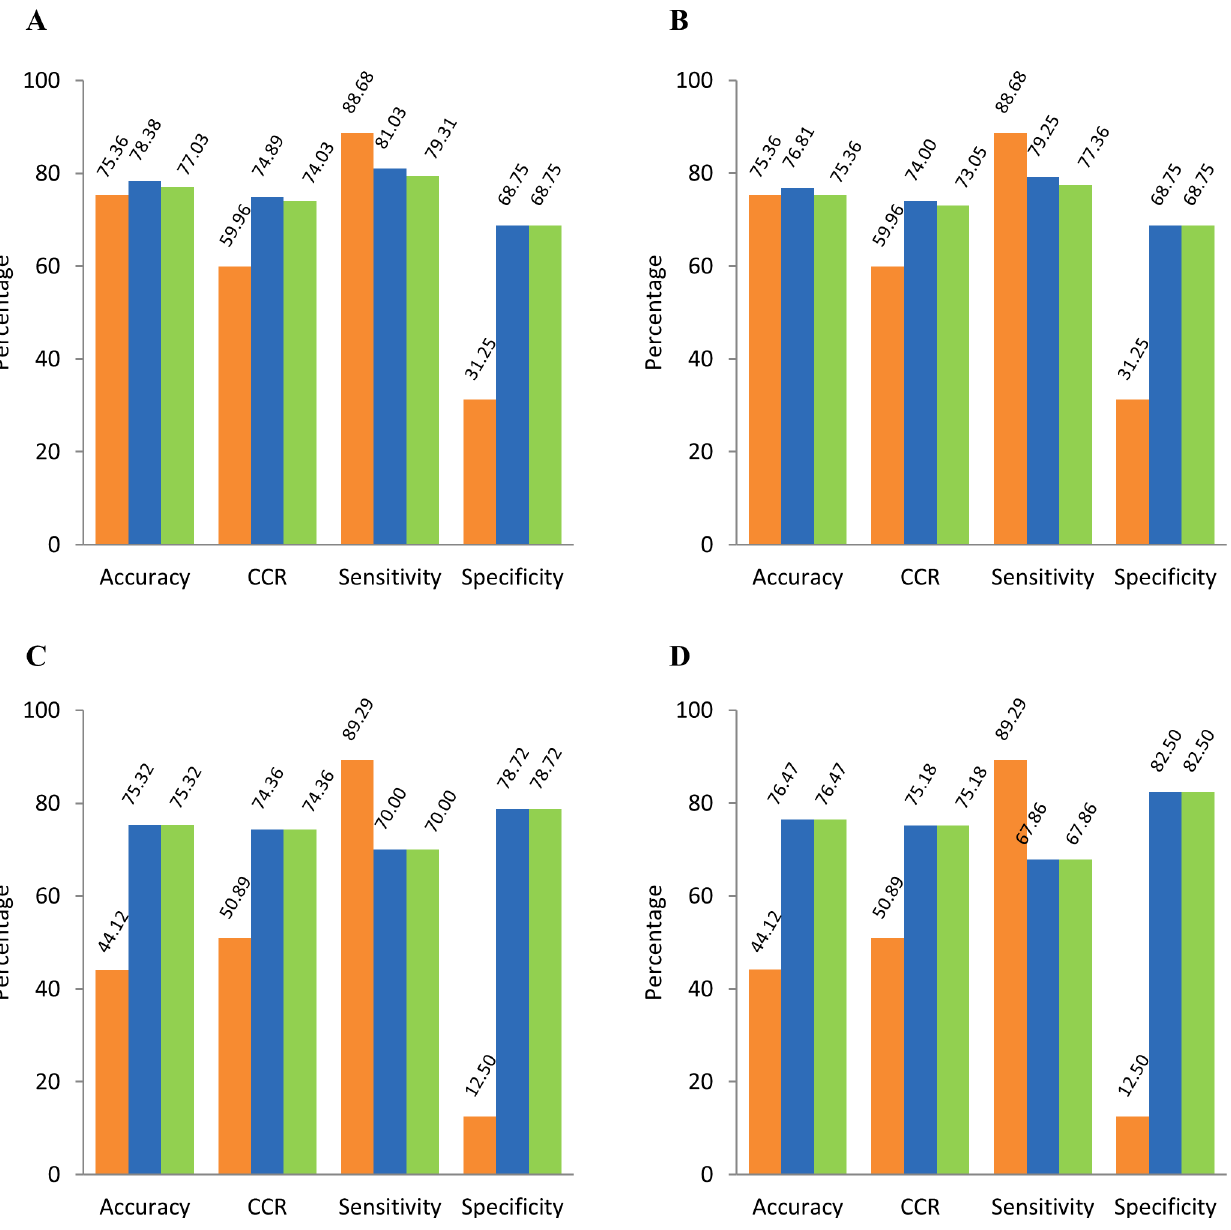
Fig 5. Comparative performance of our prediction workflows with VEGA v1.08. Panel A: Molecules of challenge set-1 processed by our prediction workflows (= 74) and VEGA v1.08 (= 69) used for computation; Panel B: 69 molecules of challenge set-1 processed by our prediction workflows as well as VEGA v1.08 were used for computation; Panel C: Molecules of challenge set-2 processed by our prediction workflows (= 77) and VEGA v1.08 (= 68) used for computation; Panel D: 68 molecules of challenge set-2 processed by our prediction workflows as well as VEGA v1.08 were used for computation. VEGA v1.08: orange bars; PW-1: blue bars; PW-2: green bars. CCR: Correct Classification Rate.